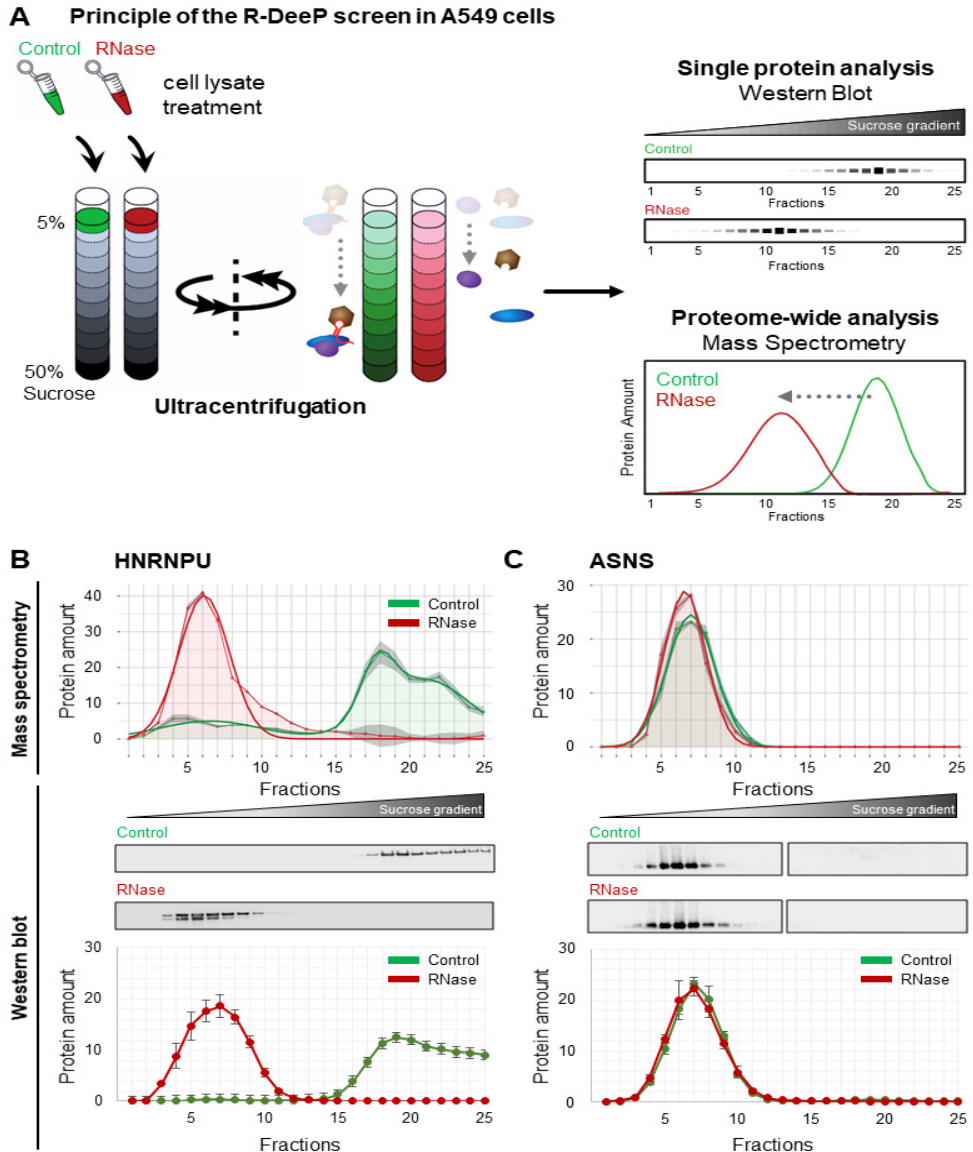
Figure 1. R-DeeP sucrose density gradient method and controls. ( A ) A549 lysates were left untreated (Control) or treated with RNase and loaded onto the sucrose gradients, which were then subjected to ultracentrifugation and fractionated into 25 fractions. The triplicates of the gradients were analyzed using mass spectrometry or Western blot. Adapted from [49]. ( B ) The top panel shows the mass spectrometry analysis of the protein HNRNPU depicting the distribution of protein amount across the 25 fractions in the control and RNase-treated gradients. Raw data showing the mean of three replicates is indicated by the curve with points and the smooth curve represents a Gaussian fit (Green: Control, Red: RNase-treated) that is part of the statistical analysis [30]. The overall protein amount was normalized to 100. The middle panel shows a representative example of the Western blot analysis of the protein HNRNPU and its distribution across 25 fractions in control and RNase-treated gradient samples. The bottom panel depicts the quantification of three replicates of the Western blot analysis (mean and SEM) for comparison to the mass spectrometry data. ( C ) Same as in 1B for the negative control protein ASNS. Original blots: see File S1.